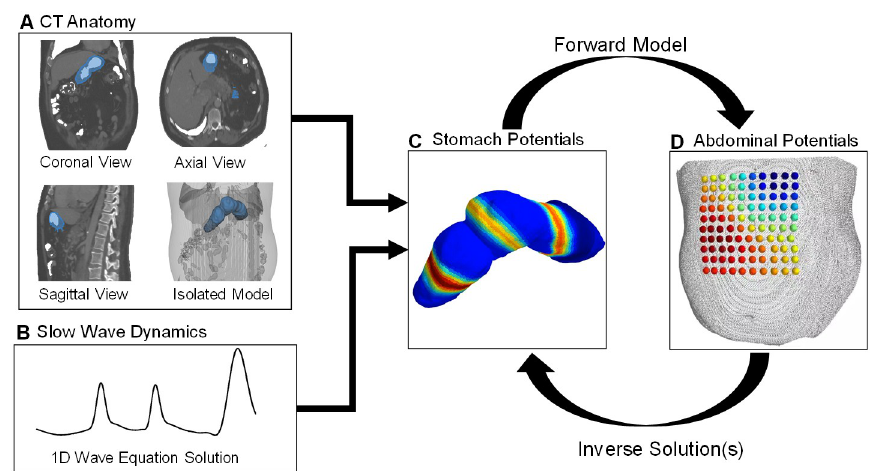
Fig 1. Process workflow. A) Using the 3 standard CT views, a 3D model of the stomach is extracted. B) We develop a spatially inhomogeneous solution to the 1D wave equation, pertaining to propagation down the organoaxial direction of the stomach, with region-specific amplitudes and speeds based upon recent findings in the literature from invasive human recordings. C) The 1D wave equation solution is mapped to the 3D model to generate the dynamic dipole moment solution. D) We solve a forward model to generate the dynamic simulated observations and inject additive measurement noise.